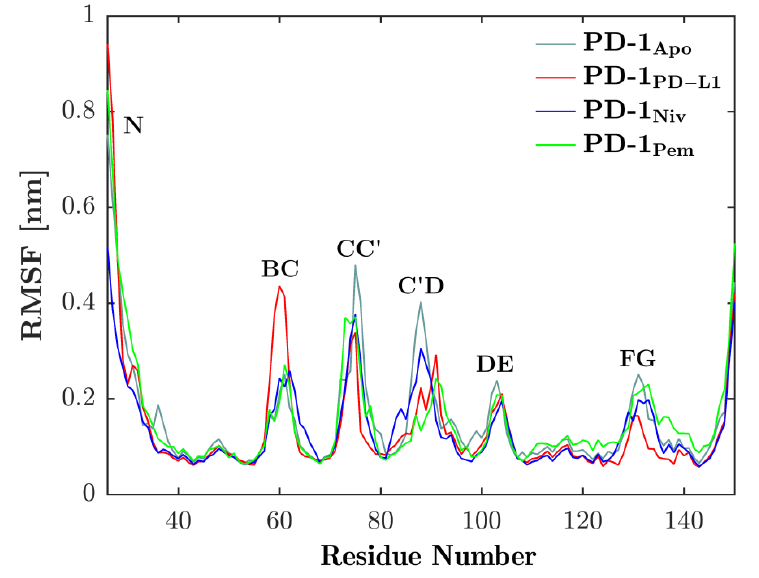
Figure 3. Binding partners reduce flexibility of CC (cid:48) -loop. RMSF of C α s (see residue number on hori- zontal axis) of PD-1 is shown for binding partners PD-L1 (red), nivolumab (blue) and pembrolizumab (green). Each of the binding partners decreases the flexibility of the CC (cid:48) -loop in comparison to the unbound state (cyan). Except for the BC-loop, a similar behavior can be seen in the other